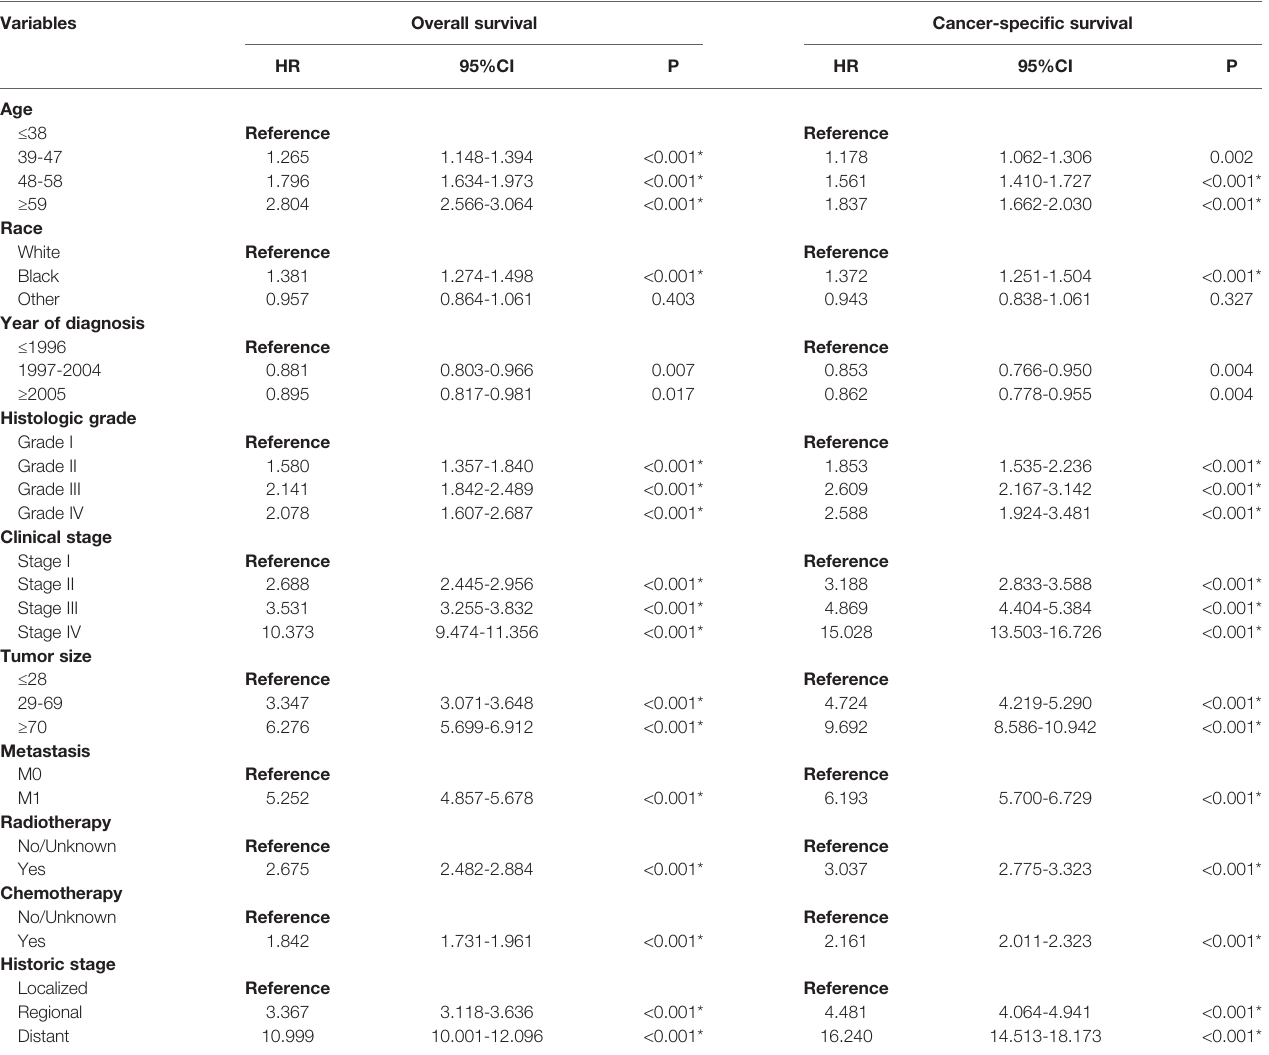
TABLE 2 | Univariate Cox regression analysis of overall survival and cancer-speci fi c survival in cervical squamous cell carcinoma (training cohort). Variables